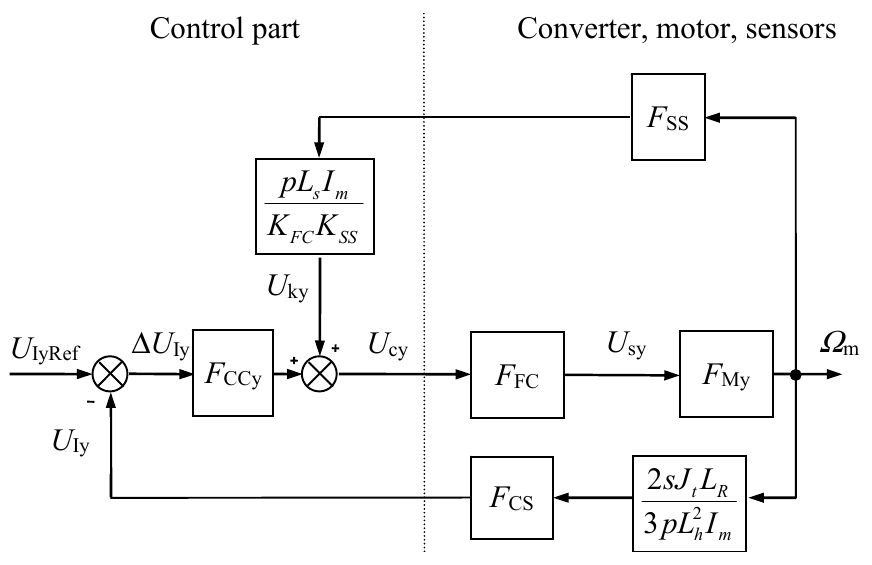
Figure 7. Adjusted torque-producing stator current control structure with decoupling block.